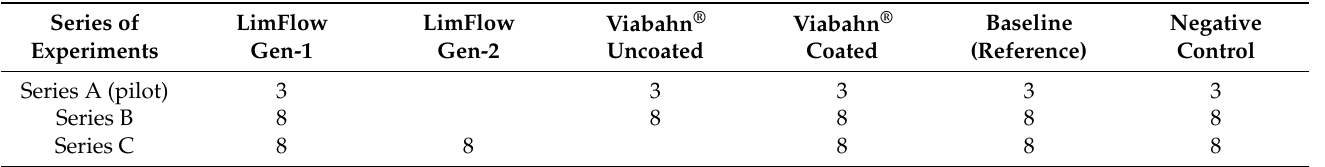
Table 1. Type and number of